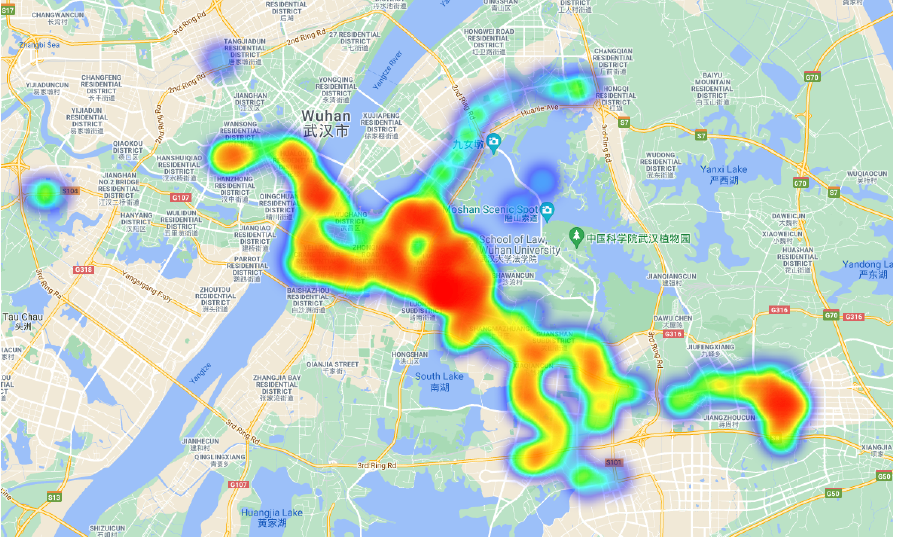
Figure 5. The heat map of the trajectory data in the real